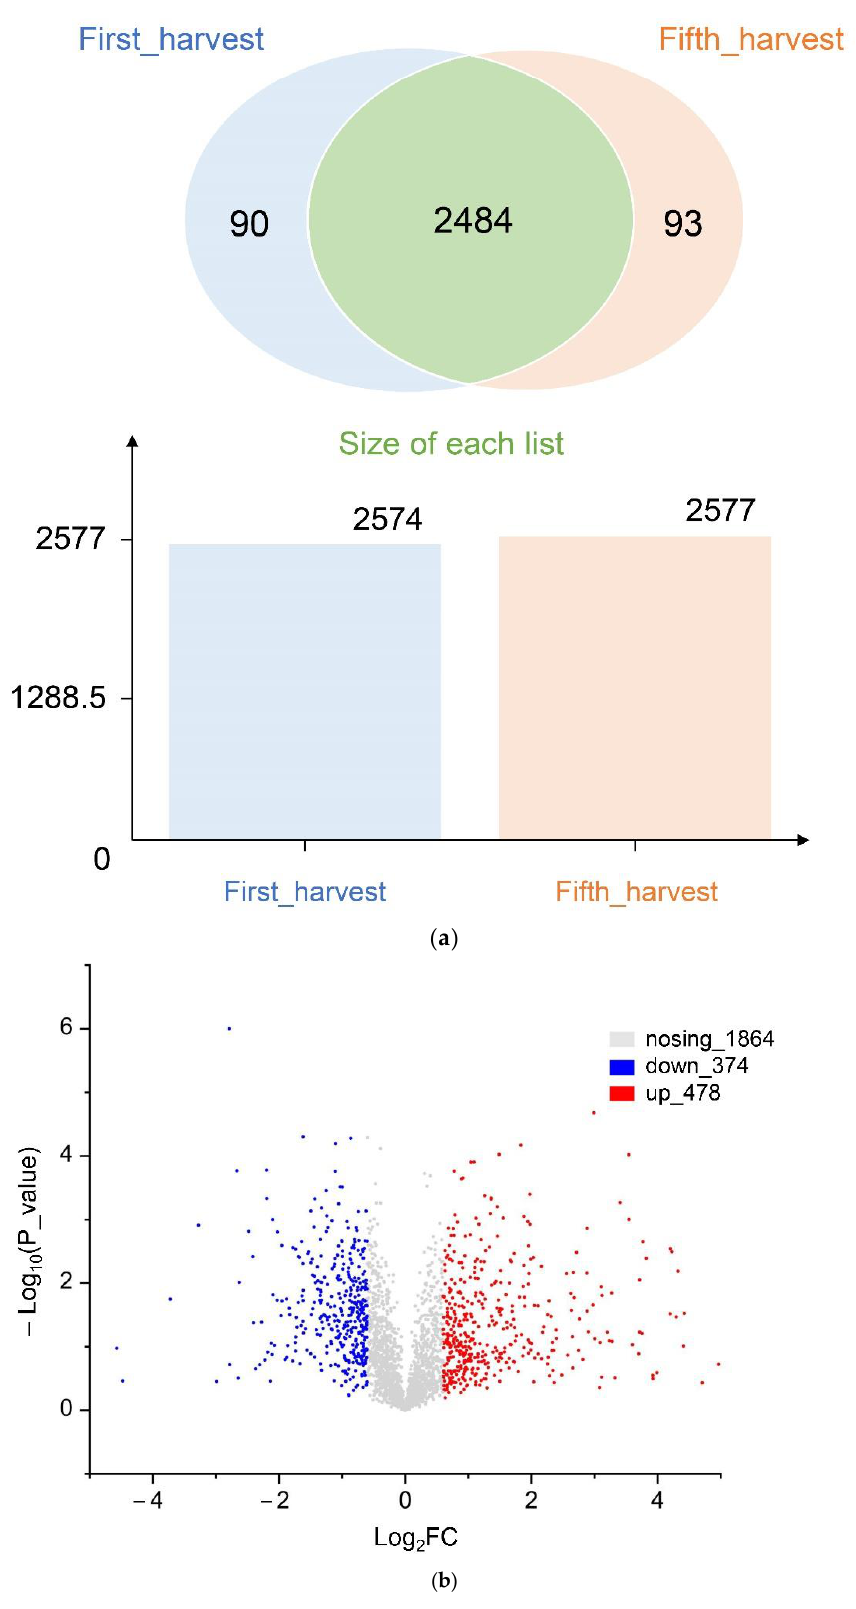
Figure 1. Label-free proteomic analysis: ( a ) First/Fifth harvest protein Venn of P. dentata . ( b ) Volcano plot of differentially abundant proteins (DAPs) from P. dentata (threshold = | log2 (fold change) |>1.2 or <0.83 and p <